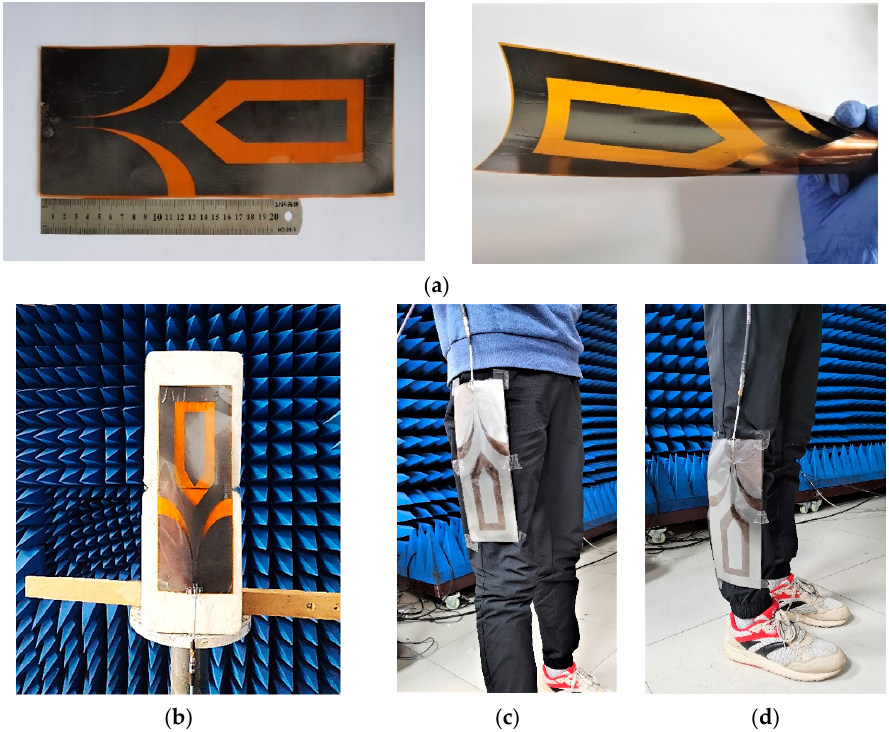
Figure 13. ( a ) Photographs of the fabricated wearable antenna. Experiment setup for different loading positions. ( b ) Free space. ( c ) Thigh area. ( d ) Shank area.